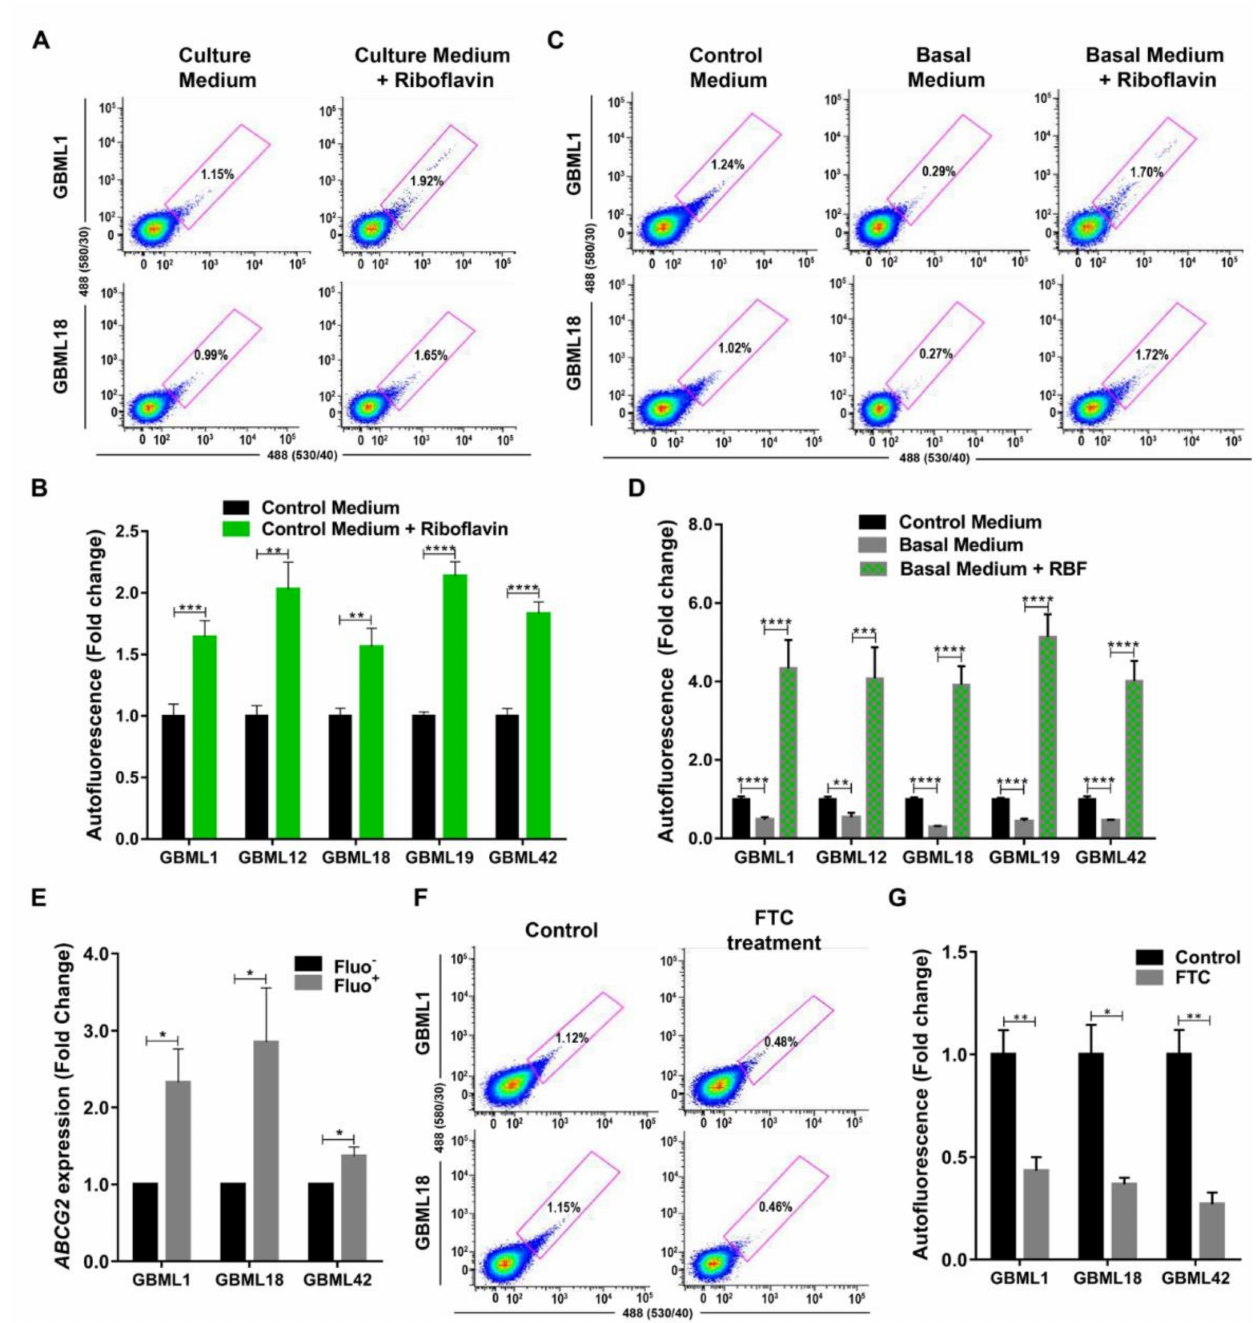
Figure 5. Riboflavin contributes to the autofluorescence phenotype of GBM stem cells. ( A,B ) Representative flow cytometry plots ( A ) and quantification ( B ) of Fluo + cells from primary GBML1 and GBML18 cultures in control medium, or control medium supplemented with 40 µ M of riboflavin. ( C,D ) Representative flow cytometry plots ( C ) and quantification ( D ) of Fluo + cells from primary GBML1 and GBML18 cultures in control medium, basal medium (without vitamins), or basal medium supplemented with 40 µ M of riboflavin (RBF). ( E ) RT–qPCR analysis of ABCG2 transporter in Fluo − and Fluo + sorted cells from GBML1, GBML18, and GBML42 primary cultures. Data are normalized for TBP expression and represent the relative ratios between Fluo + and Fluo − . ( F,G ) Representative flow cytometry analysis ( F ) and quantification ( G ) of aut- ofluorescence in GBML1 and GBML18 cultures treated with 5 µ g/mL of fumitremorgin C (FTC). Data from ( B , D , E , G ) panels are represented as the mean ± SD of at least three independent experiments; ( A , C , F ) panels are representative plots of at least three independent experiments (* p ≤ 0.05, ** p ≤ 0.01, *** p ≤ 0.001, **** p ≤